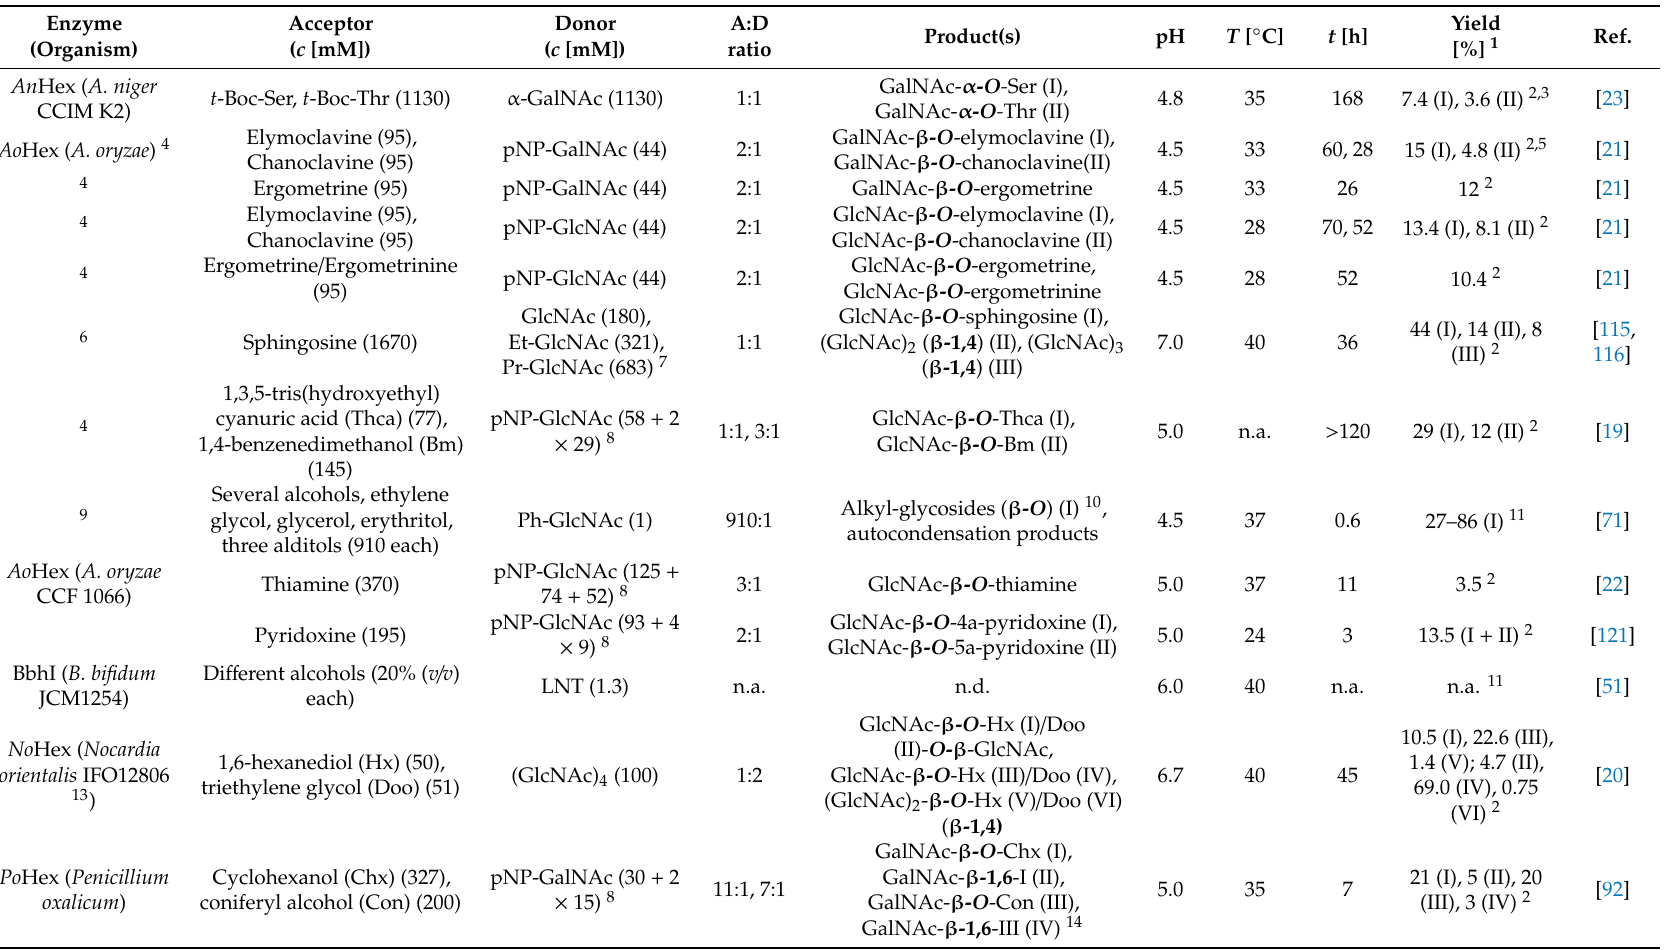
Table 10. Synthetic trans-glycosylation reactions using non-carbohydrate acceptors catalyzed by GH20 β - N -acetyl hexosaminidases. New bonds are highlighted in